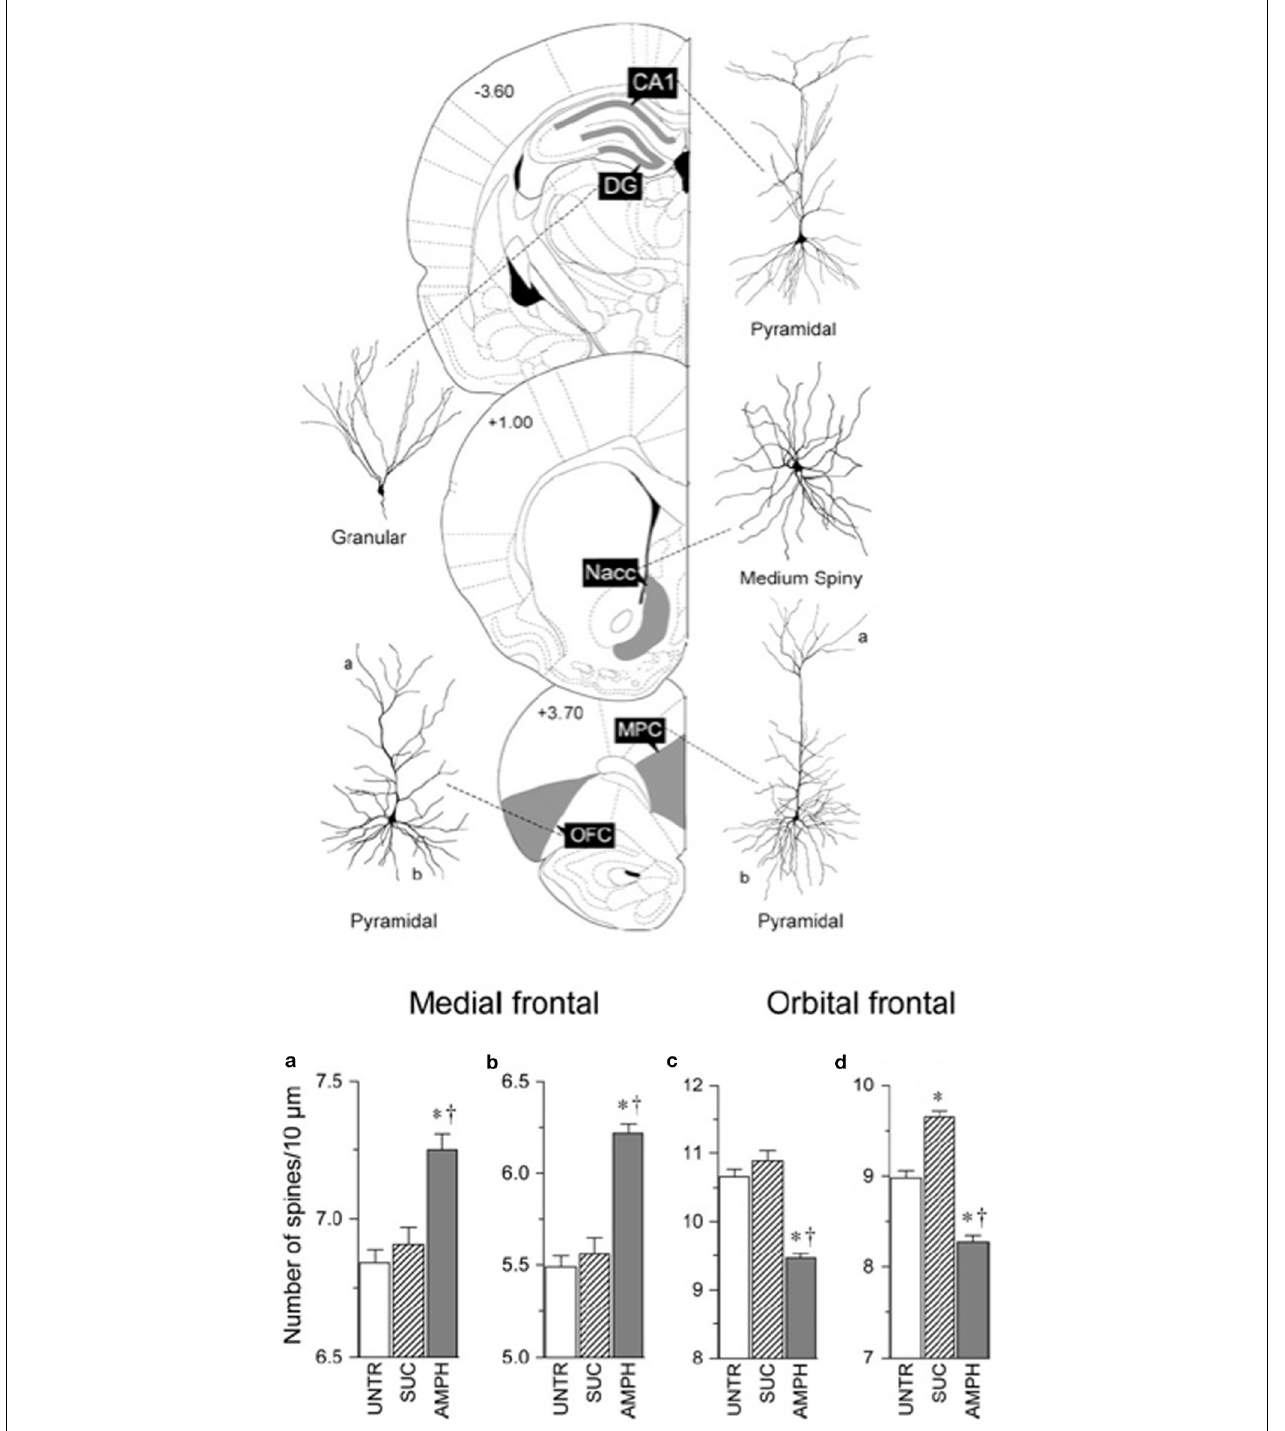
FIGURE 2 | Top: Illustration of location of, and cell morphology, for the analysis of the effects of amphetamine on neuronal structure. Bottom : Summary of the contrasting effects of amphetamine on the medial frontal and orbital